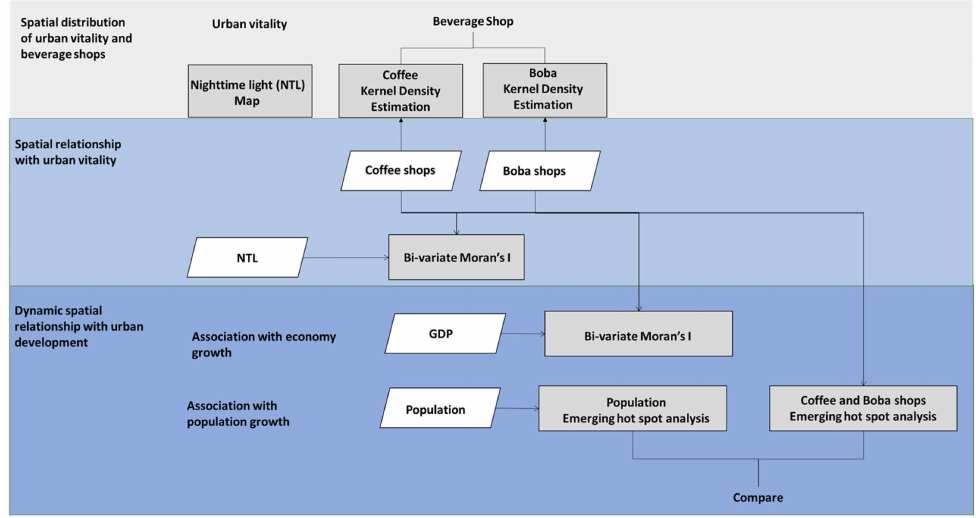
Figure 5. Research